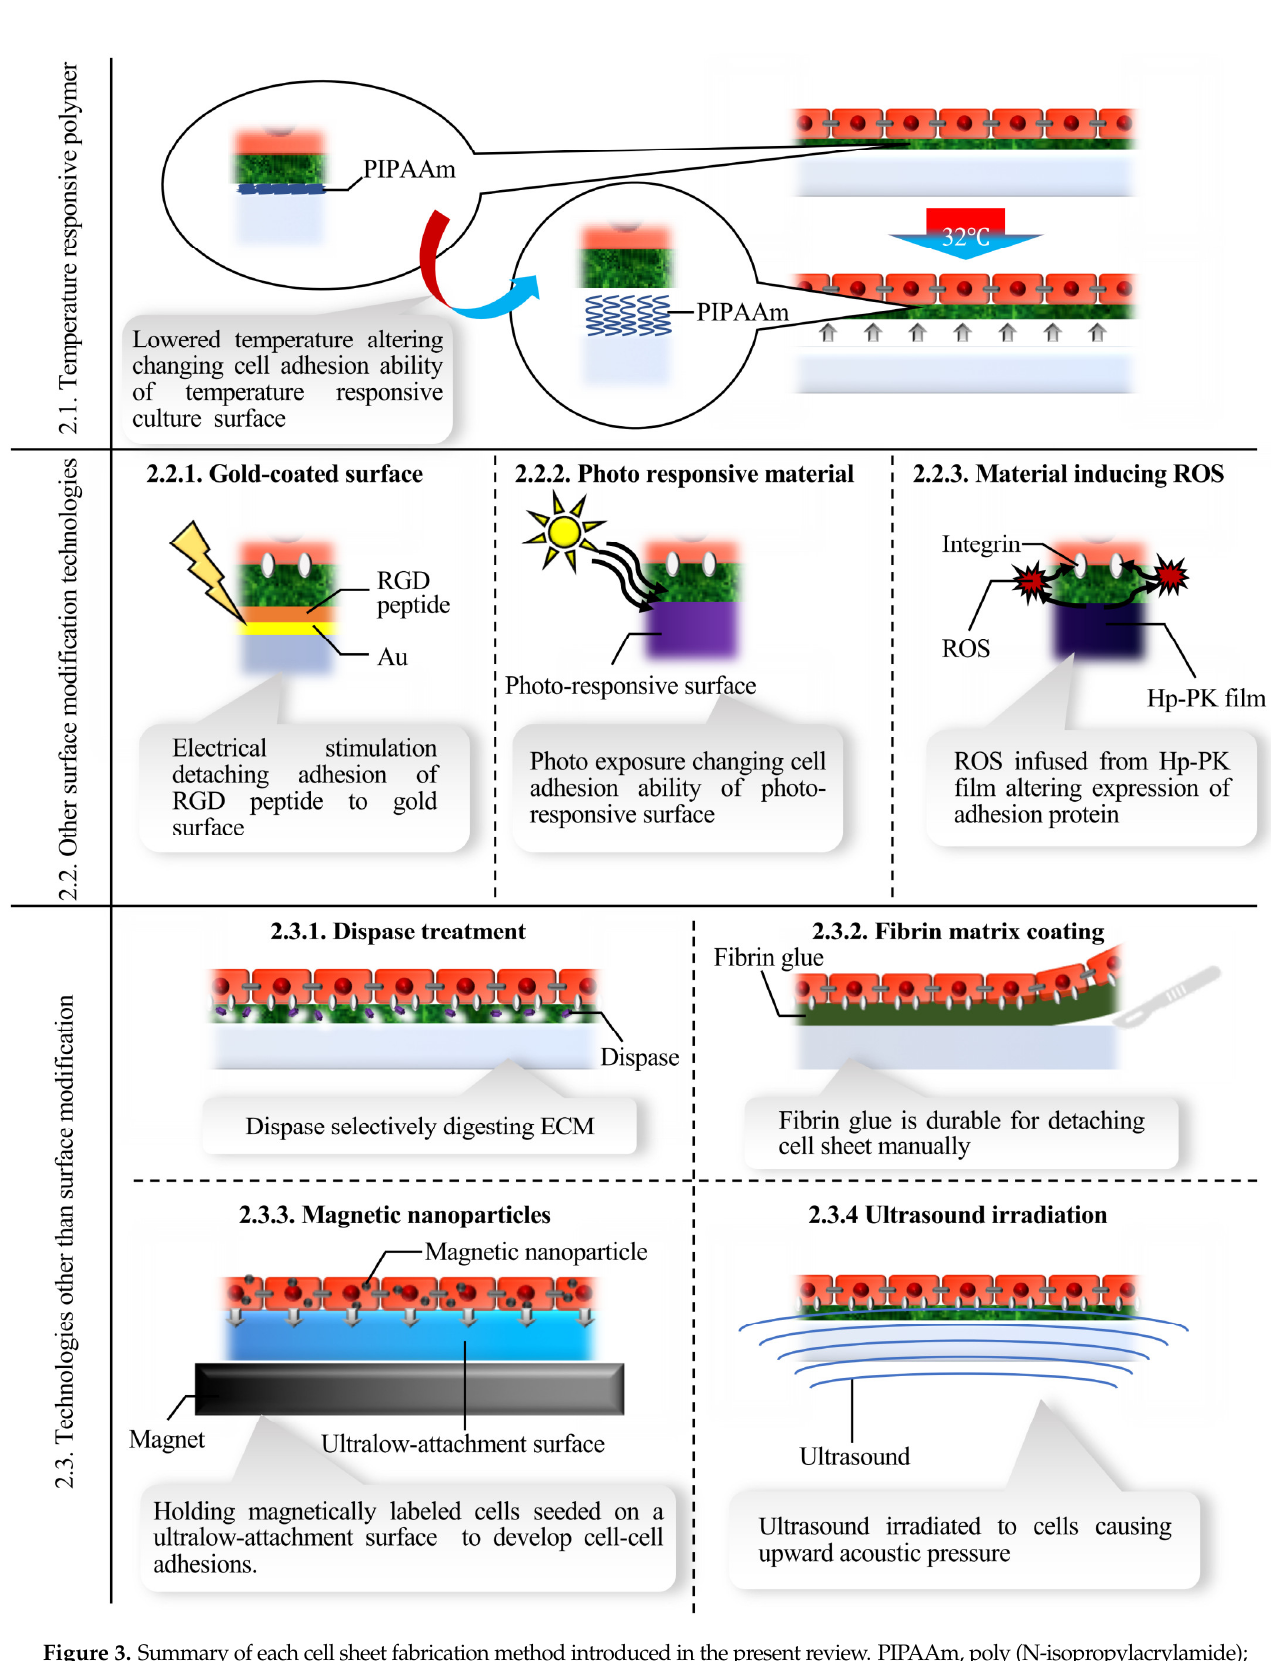
Figure 3. Summary of each cell sheet fabrication method introduced in the present review. PIPAAm, poly (N-isopropylacrylamide); RGD, Arg–Gly–Asp; Au, gold; ROS; reactive oxygen species; Hp-PK, hematoporphyrin-incorporated polyketone; ECM, extracellular matrix.